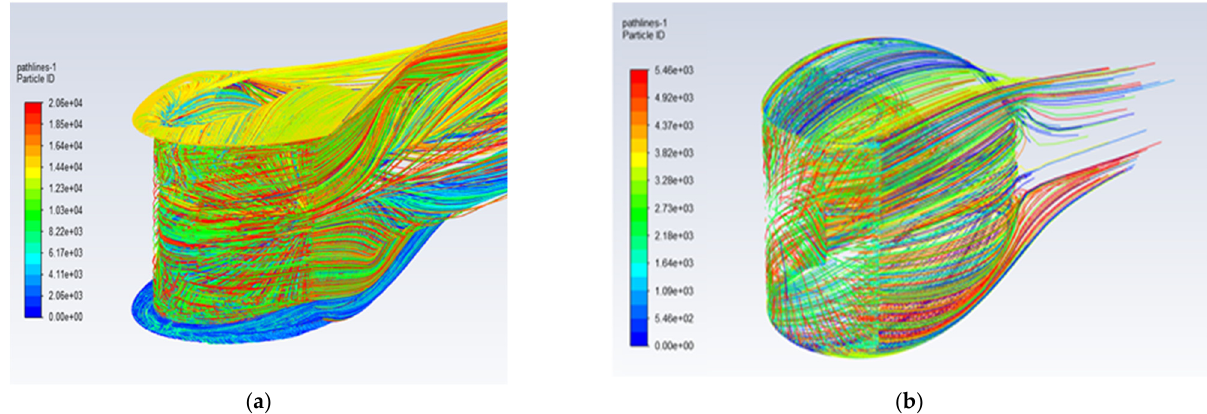
Figure 7. Stream lines on convex contour: ( a ) Novel Blade geometry; ( b ) Savonius-type blade.